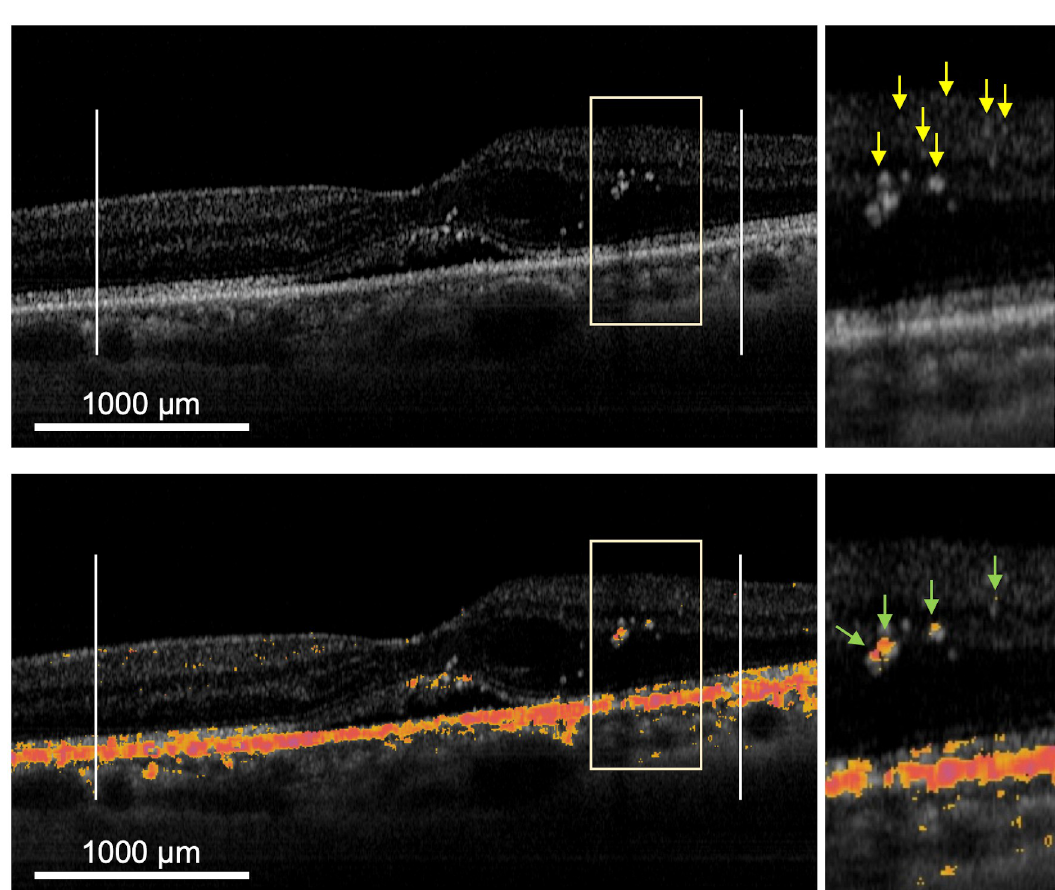
Fig 4. Evaluation of the number of entropy signals along with HRF. Intensity images on PS-OCT B-scan (upper) and overlapped image with signalized entropy (set as > 0.1) on its intensity OCT image (lower) of DME patient are shown. Each image obtained by scanning through the fovea within a 1500 μ m radius centered on the fovea was selected (delimited with two vertical markers traced at established distances, left side of each). The numbers of HRF and dots of entropy signals in the retina were evaluated. The pictures on the right side of each picture are a partial enlarged image and yellow and green arrows indicate HRS and entropy signals, respectively. HRF, hyperreflective foci; DME, diabetic macular edema. 26.1 ± 9.8, and 28.2 ± 18.3 at the baseline and 1-month, 2-month, 3-month, and 6-month time- points, respectively. Although the changes were not significant, the entropy in the RPE tended to decrease at the 3-month and 6-month time points (P = 0.14, P = 0.14).